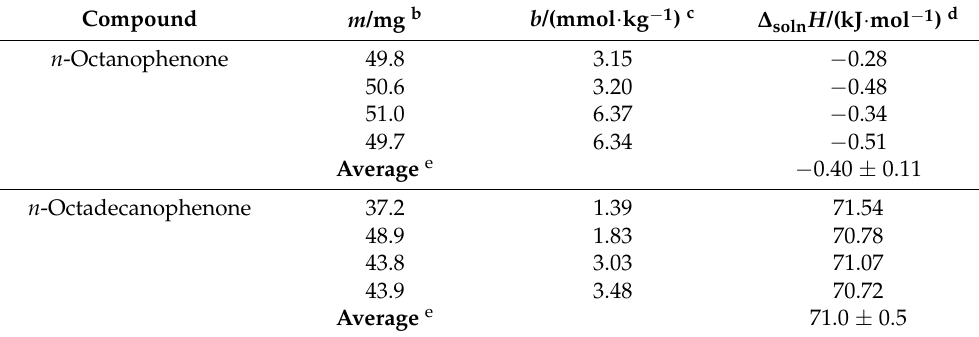
Table 2. The solution enthalpies of phenones in p -xylene measured in this work at 298.15 K and 0.1 MPa a